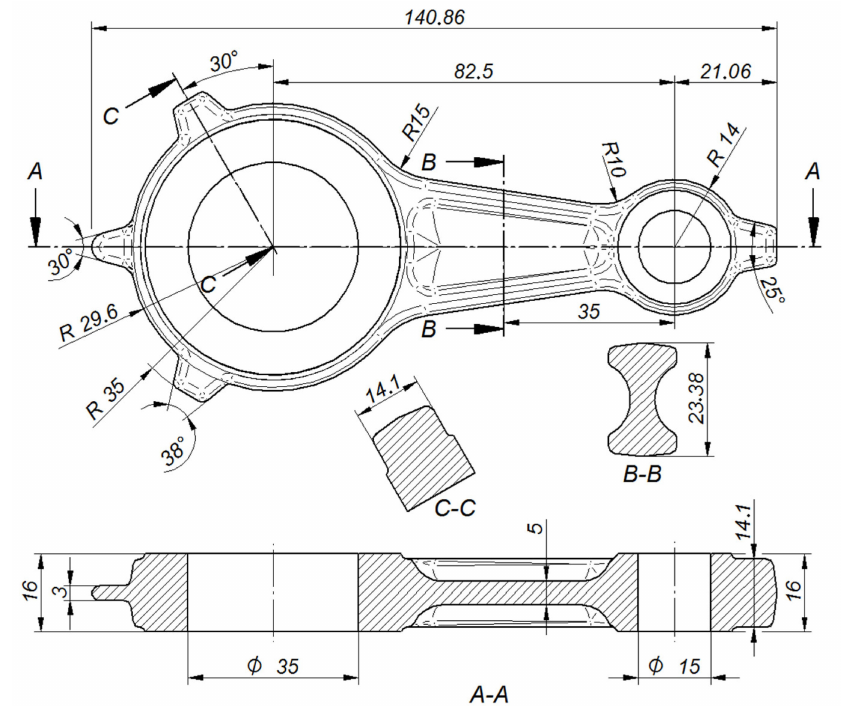
Figure 2. Selected dimensions of the finished connecting